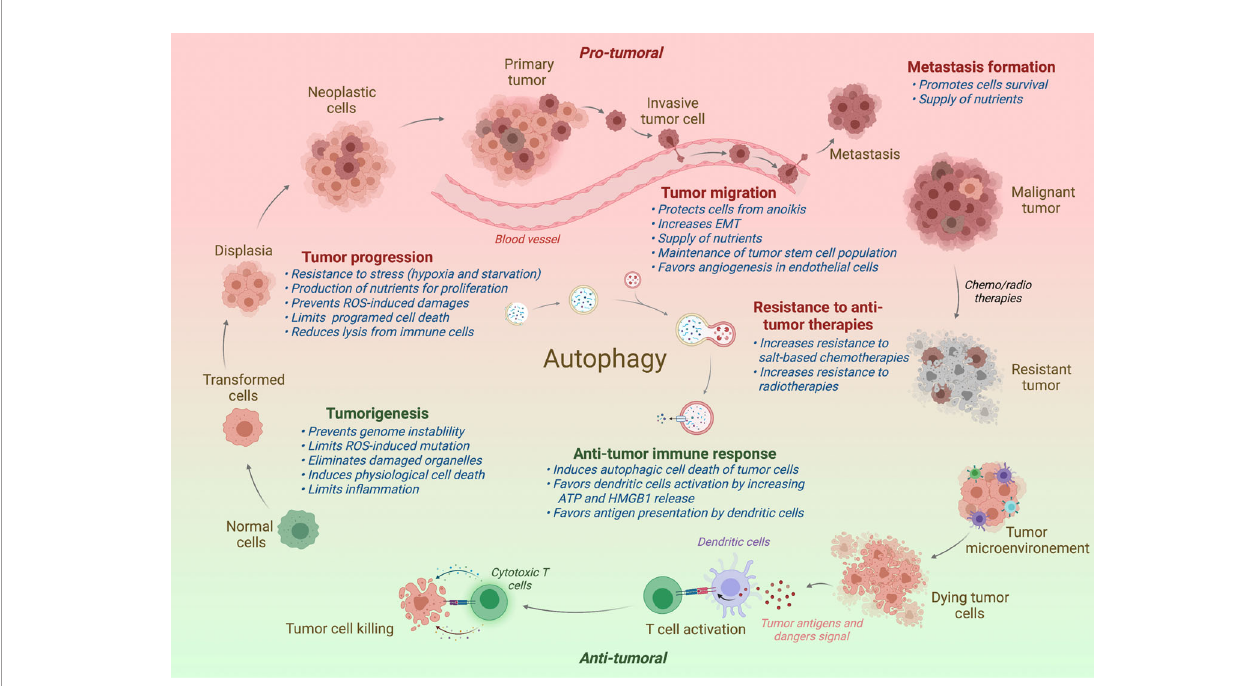
FIGURE 2 | Impact of autophagy on tumor progression. In normal cells, autophagy restricts the tumorigenesis by limiting genome instability and strong in fl ammation. However, when the tumor is established, autophagy has been shown to promote tumor development, including the tumor progression, migration, and the formation of metastasis. Autophagy has also been associated to a better resistance to antitumor radio- or chemotherapies. In contrast to support tumor, autophagy favors the antitumor immune responses, promoting the immunogenic cell death and the presentation of tumor antigens to the adaptive immune cells. Protumor effects of autophagy are written in red and antitumor effects in green. Effect of autophagy (blue) is indicated at different steps of tumor development. ROS, Radical oxygen species; EMT, Epithelial- Mesenchymal